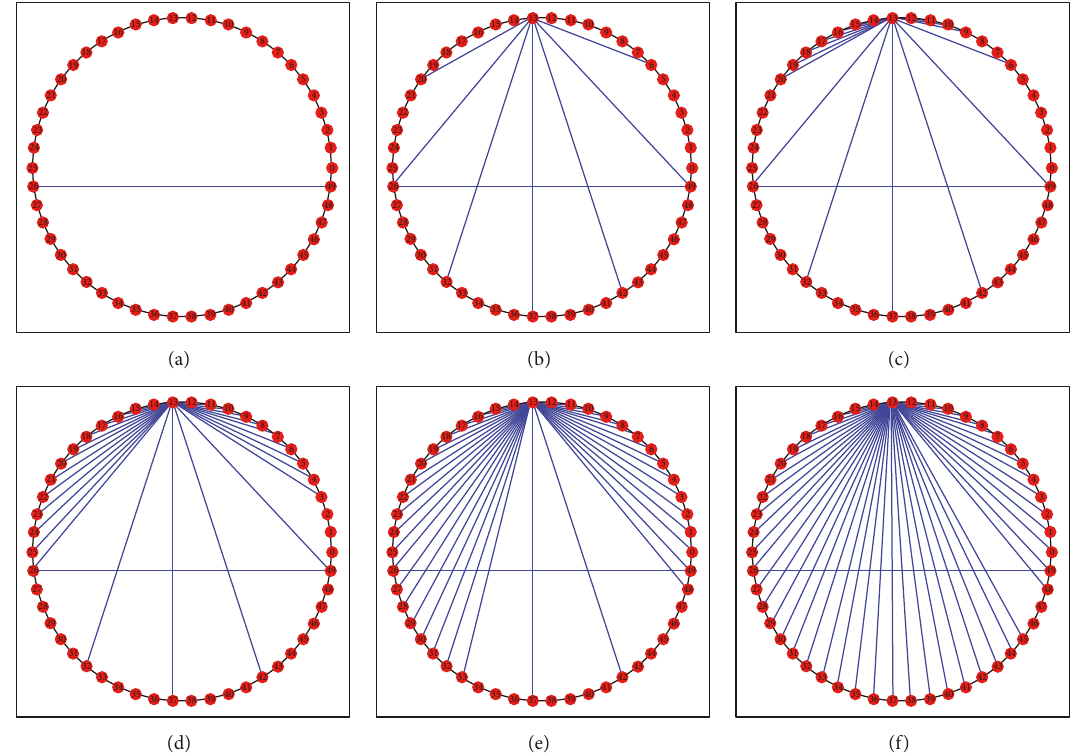
Figure 6: Optimizing results for improving efficiency of transforming a regular network into a small-world network. The figures show the topological structure of the greedy algorithm for adding edges. (a) shows the topology of the original regular network. (b)–(f) show the topology as k edges are added ( k = 10, 20, 30, 40,